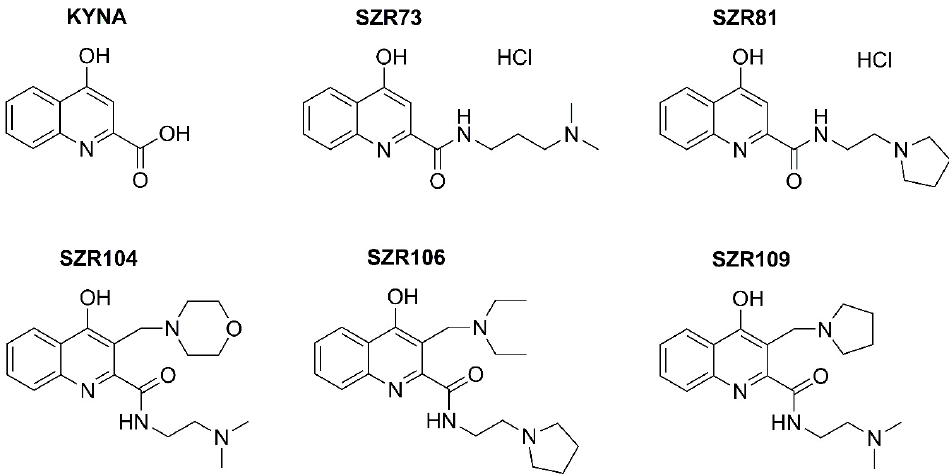
Figure 1. Formulas of kynurenic acid (KYNA) and its SZR analogs.